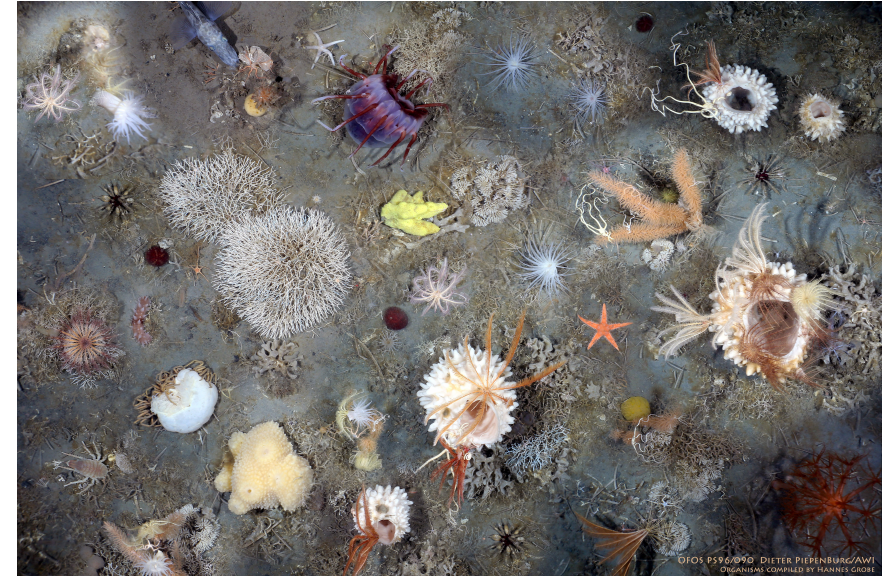
Figure 5. Example of photographic material gathered during Polarstern cruise ANT-XXXI/2 (PS96) to the Weddell Sea from December 2015 to February 2016, showing a compilation of epibenthic megafauna recorded at station PS96/090 on the shelf off the Riiser-Larsen Ice Shelf (Rampen) at water depths from 265 to 310m on 29 January 2016 (collage created from 25 clips of seabed images using Adobe